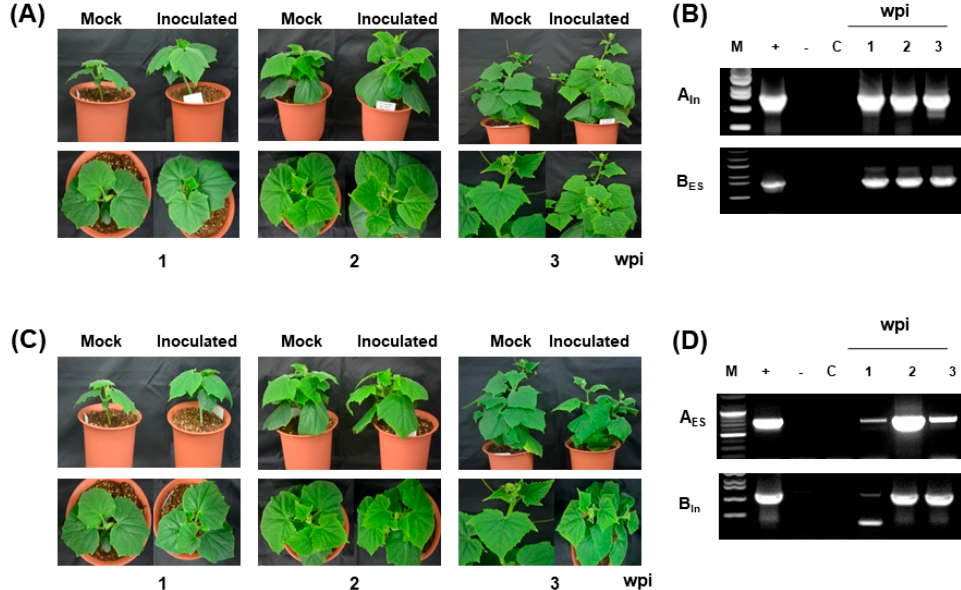
Figure 4. Summary of the swapped ToLCNDV component infection in cucumber: ( A , B ) phenotype and PCR results for ToLCNDV-India DNA A + ToLCNDV-ES DNA B (A In B ES ); ( C , D ) infectivity of ToLCNDV-ES DNA A + ToLCNDV-India DNA B (A ES B In ) by symptom appearance and PCR. Lane M, ladder; lane +, positive control; lane -, negative control; and lane C, mock plants.